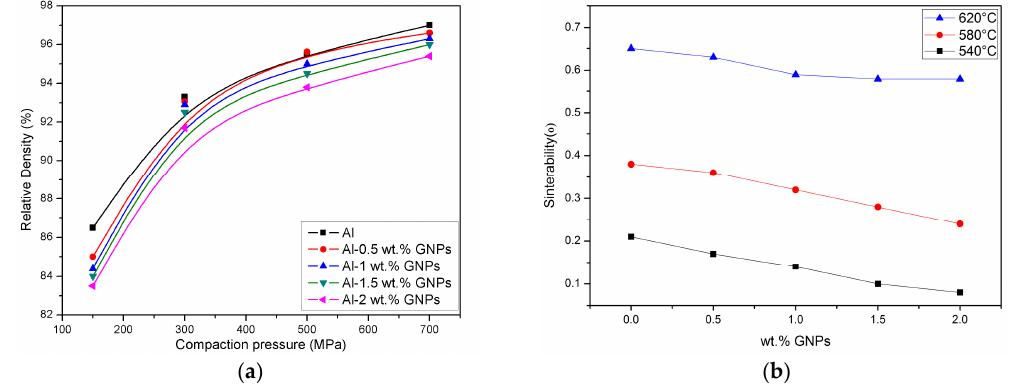
Figure 7. ( a ) Consolidation curve and ( b ) sinterability curves of Al/GNPs nanocomposites as a function of GNPs [130], Reproduced from [130], with permission from Springer Nature, 2017.